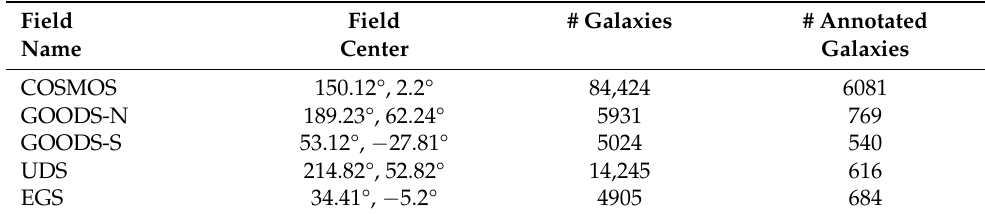
Table 1. The number of galaxies in each of the five HST fields.